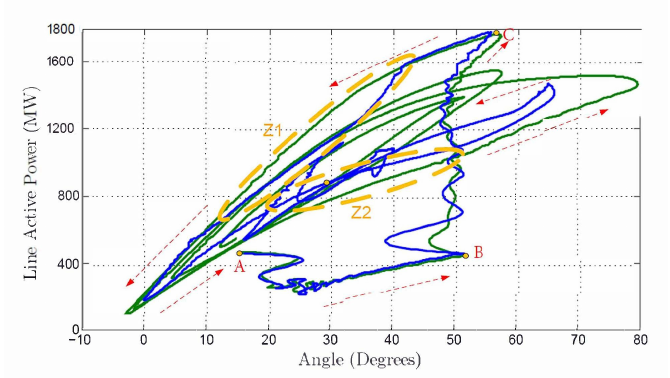
Figure 18. P- δ plot: SVC with local control case in green, and delay-compensated HIL-based WAC-SVC in